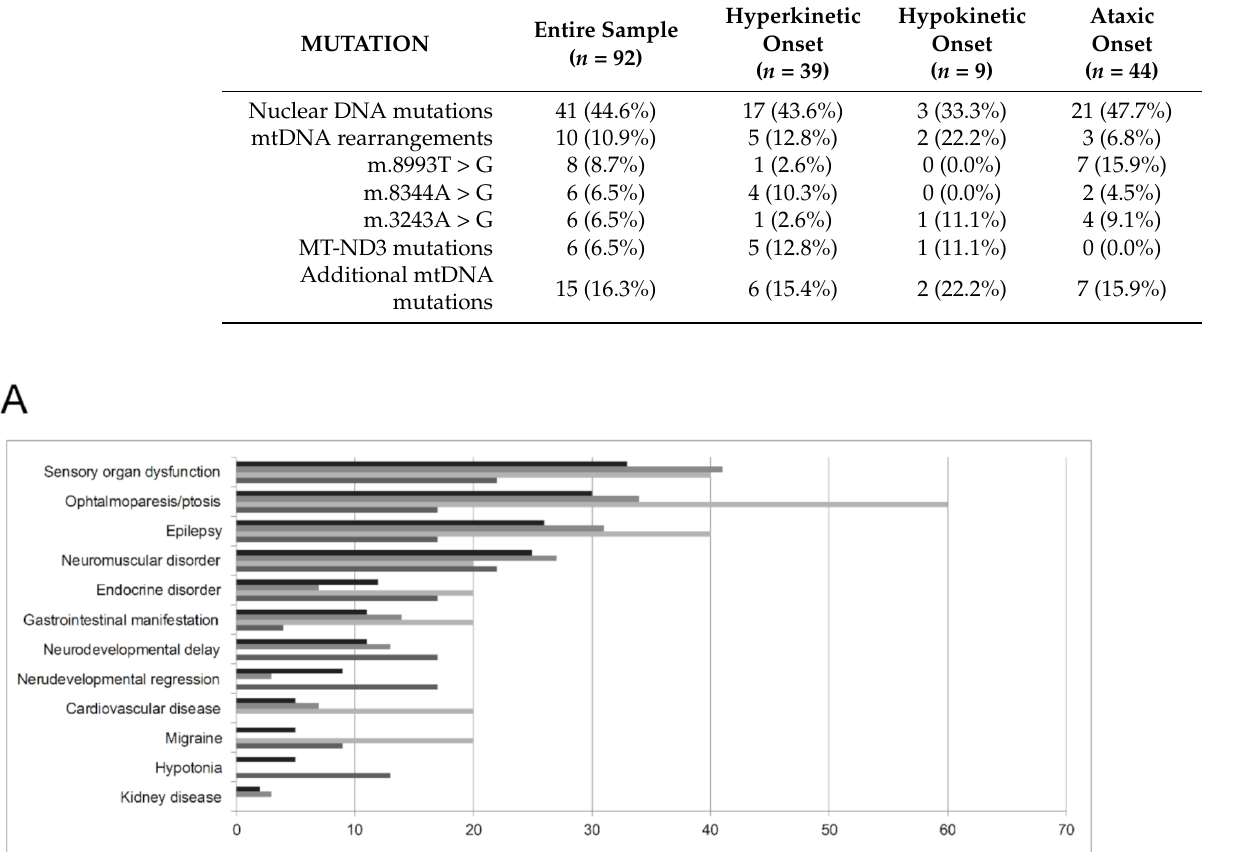
Table 3. Genetic findings underlying mitochondrial movement disorders. n = 92 (genetic data were unknown for 10 patients). No significant differences were observed between the subgroups (significance level after Bonferroni’s correction: 0.002).